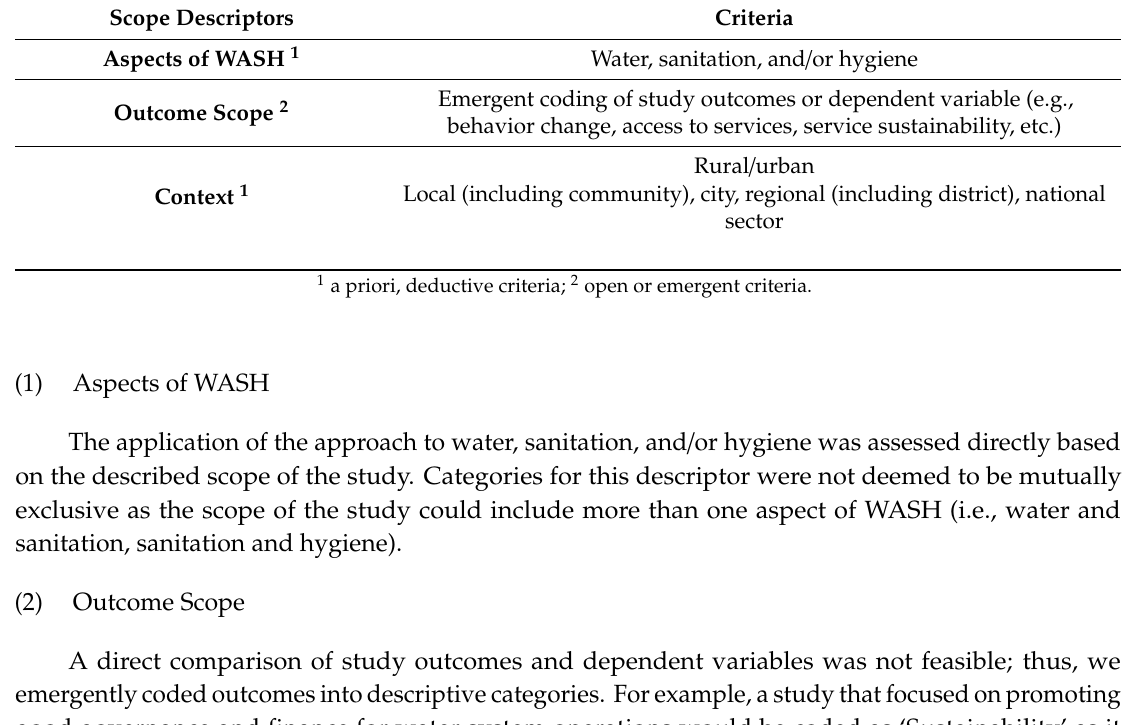
Table 2. Descriptors criteria for assessing the scope